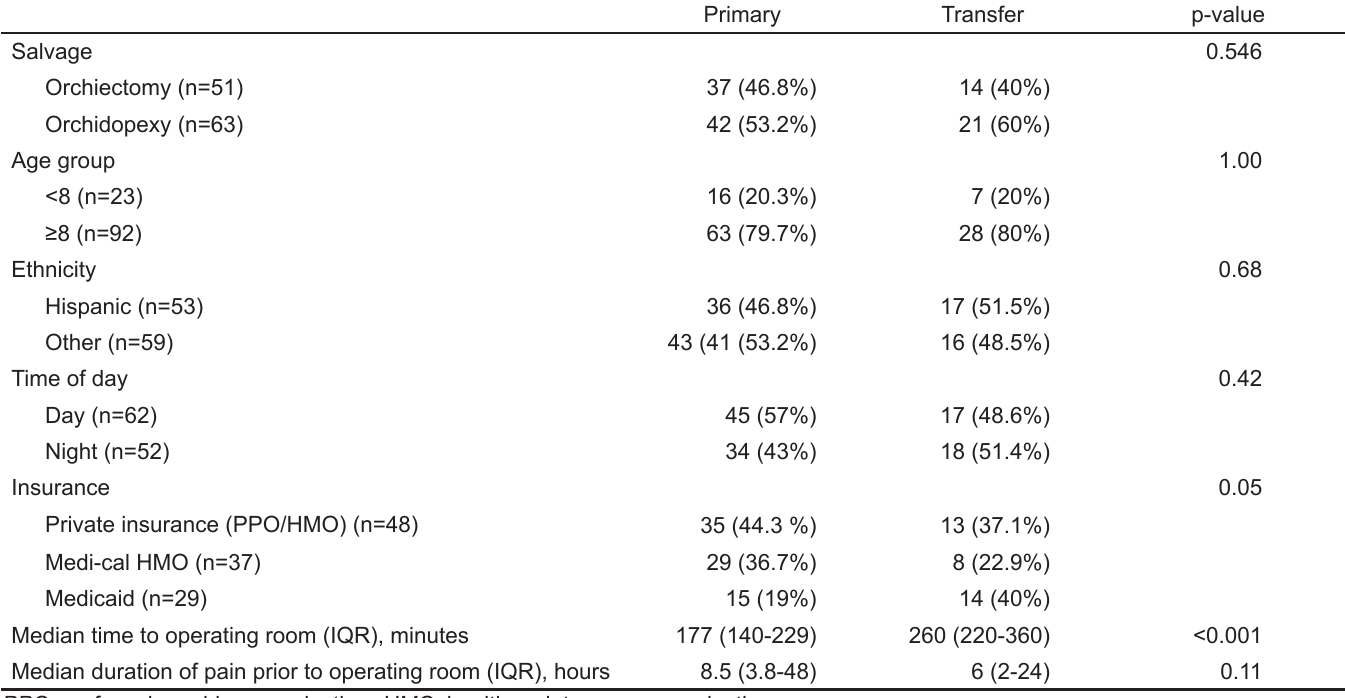
Table 2. Comparison of primary and transferred patients.